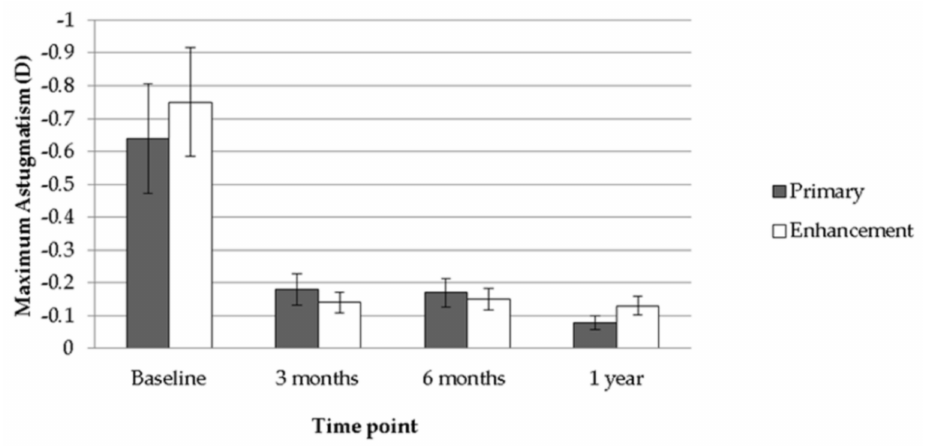
Figure 2. Comparison between the primary group and the enhancement group regarding best-corrected visual acuity. BCVA: best-corrected visual acuity; LogMAR: logarithmic scale of minimal angle of resolution.